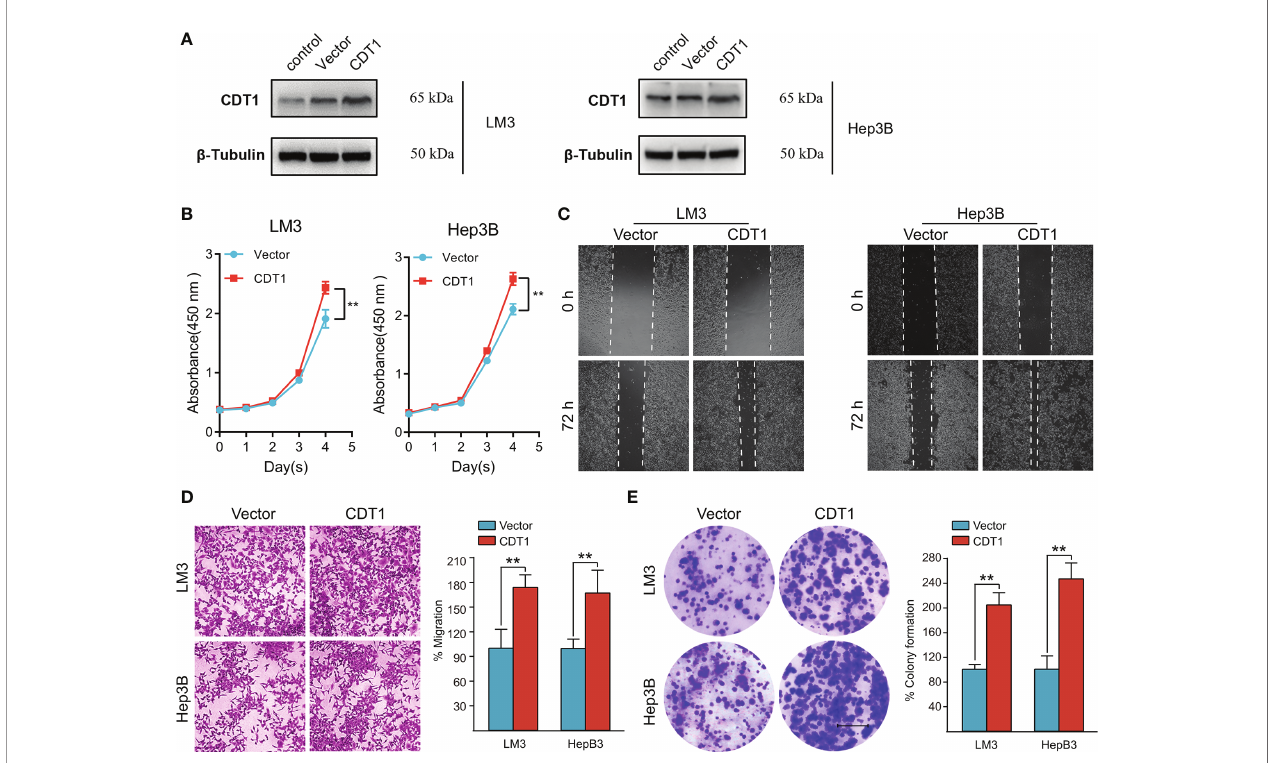
FIGURE 12 | Overexpression of CDT1 promoted the proliferation, migration and invasion of HCC cells. (A) Western blotting detection of CDT1 expression after overexpression of CDT1 in the LM3 and Hep3B cell lines. (B) The effect of CDT1 overexpression on cell viability at 24, 48, 72 and 96h after seeding in plates was measured by CCK-8 assay. (C, D) Transwell analysis and wound healing assay re fl ected the migration ability of LM3 and Hep3B cell lines. (E) Images of the colony formation assay after overexpression of CDT1 in HCC cells. Scale bars in (E) equal 5mm. Data are expressed as means ± SD of three independent experiments. ** p <